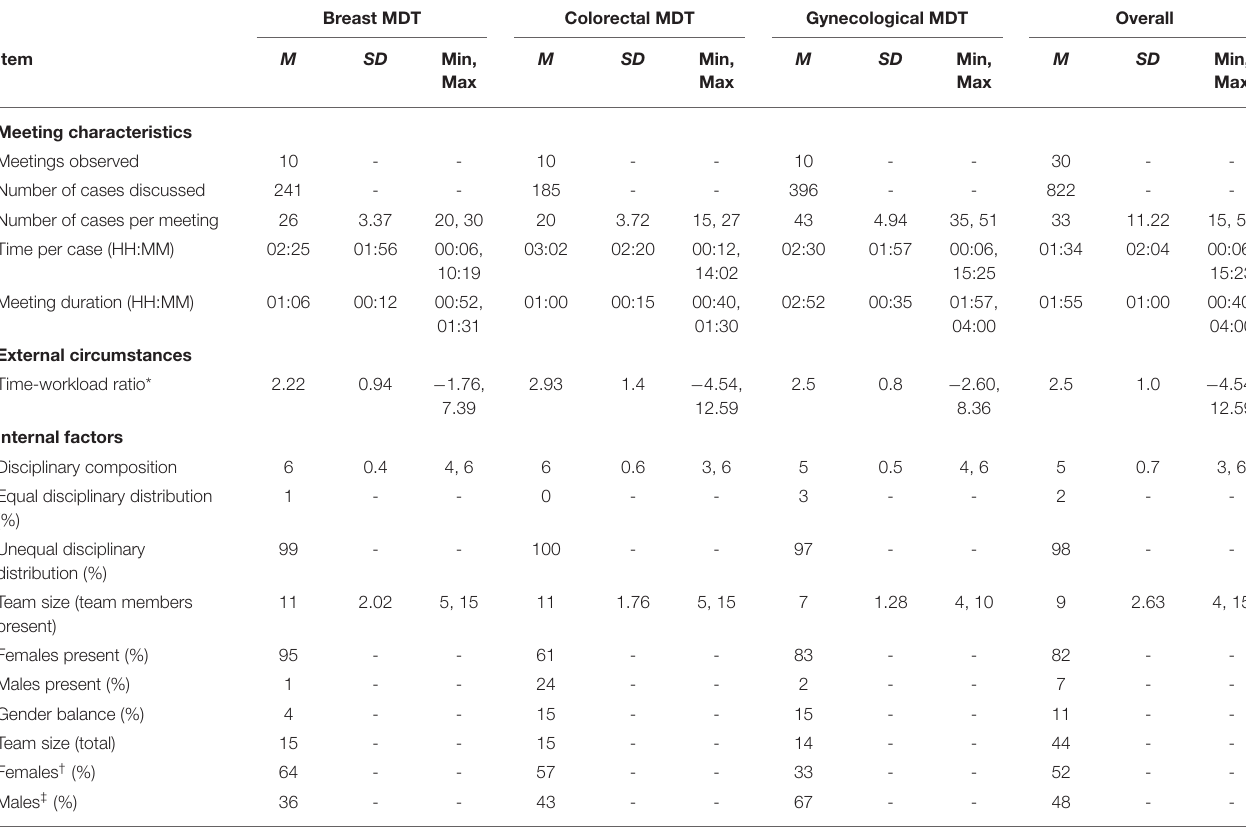
TABLE 2 | Meeting and team characteristics. Breast MDT Colorectal MDT